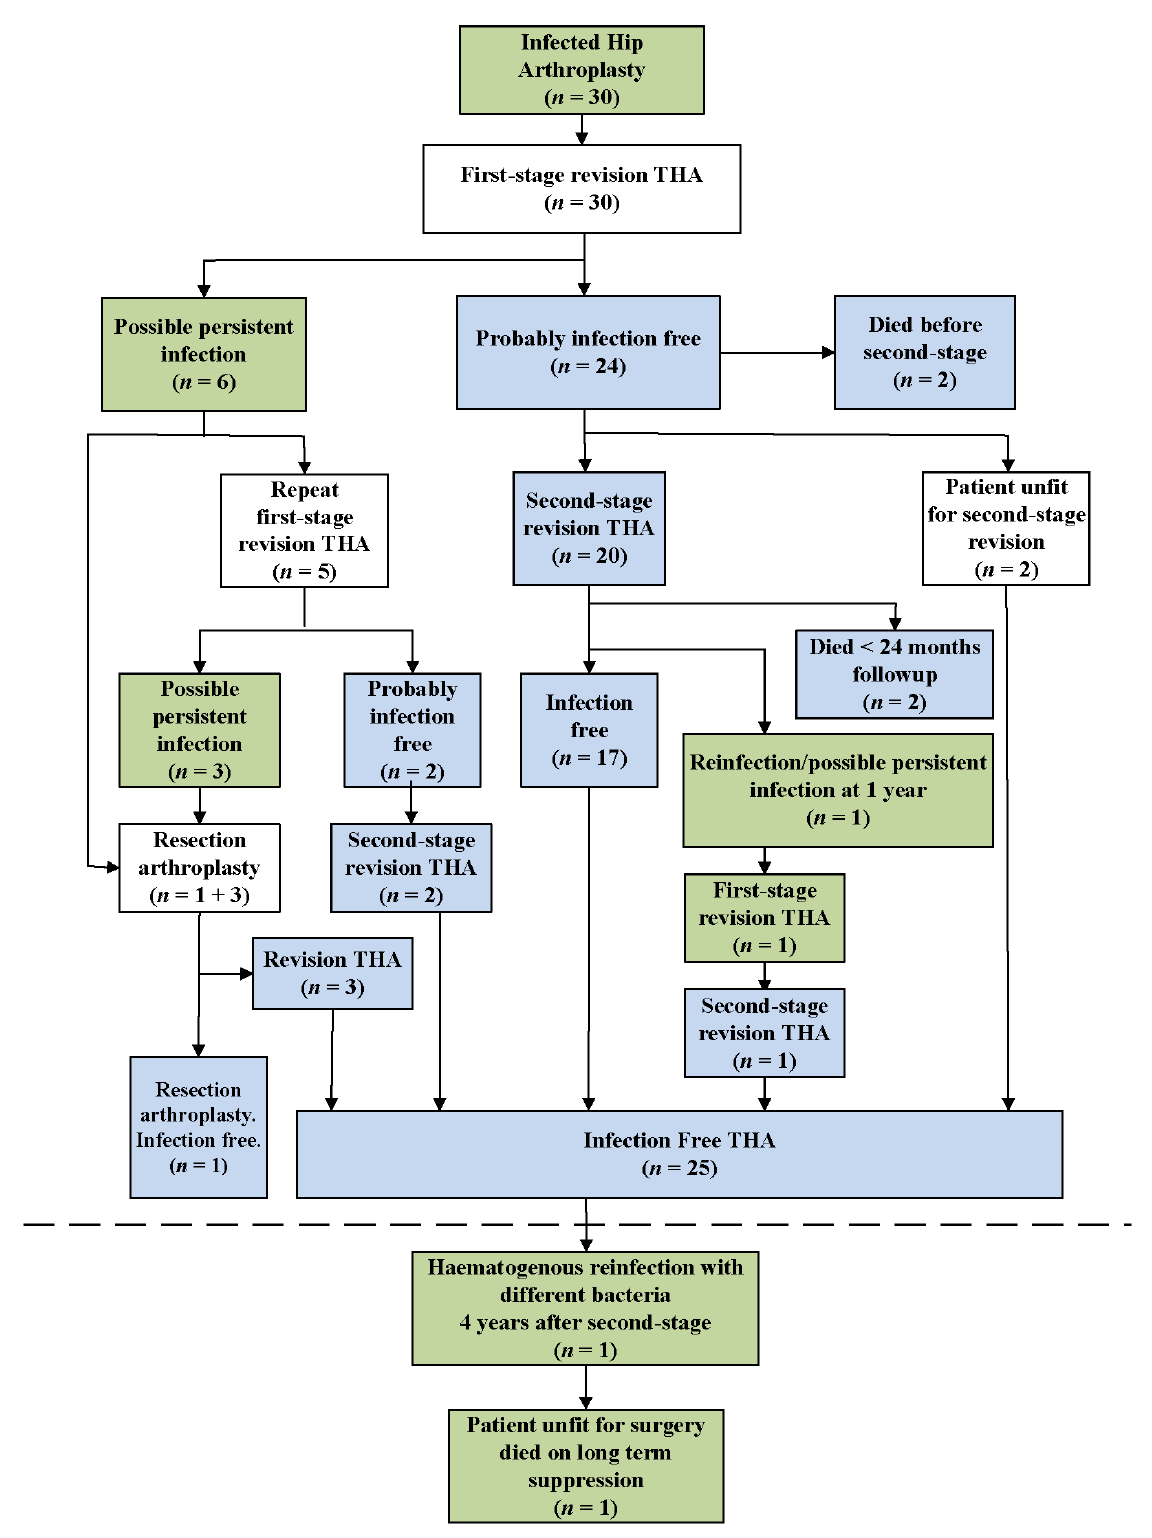
Figure 1. Surgical and infection pathways for study patients. Blue indicates an infection-free stage and green indicates a possibly infected or confirmed infection stage. Dashed line indicates end of treatment of the initial infection. Patients underwent up to four surgeries (Table 2).